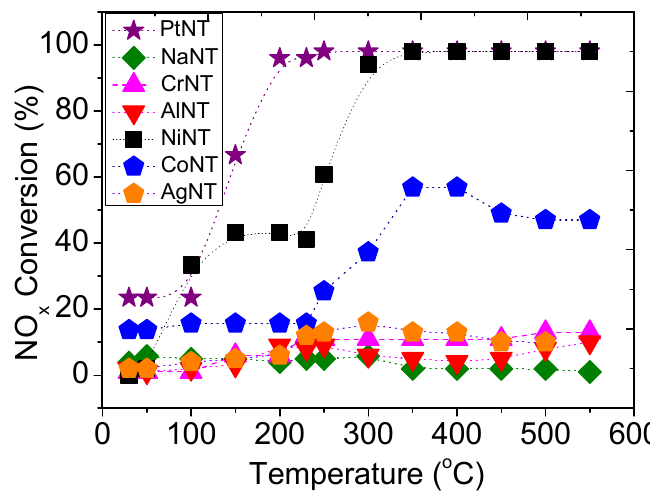
Figure 6. NO x conversions of the titanate nanotubes as a function of the temperature during CO-SCR reaction. Reaction conditions: amount of the catalyst, 0.15 g; reaction mixture, 500 ppm of NO, 1000 ppm of CO and balance in He; flow rate, 80 mL·min − 1 ; space velocity, 48,000 h − 1 .